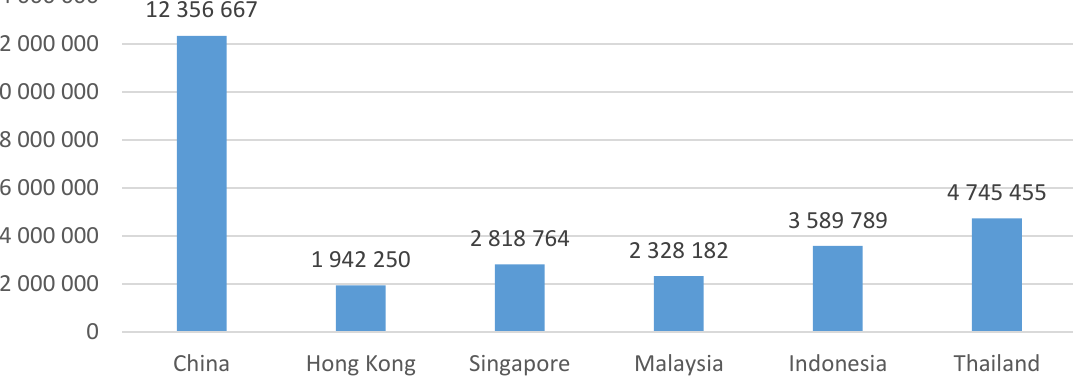
Figure 3. Average annual costs of banks’ AML Compliance operations by Asia in 2016 (USD, million)